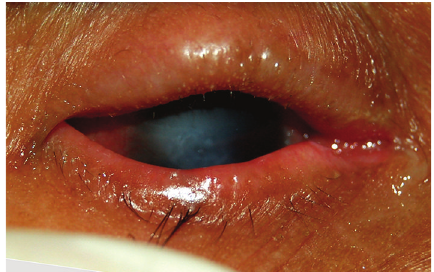
Figure 10: Corneal opacity (CO stage). Figure courtesy of Hollman Miller, Vaup´es,